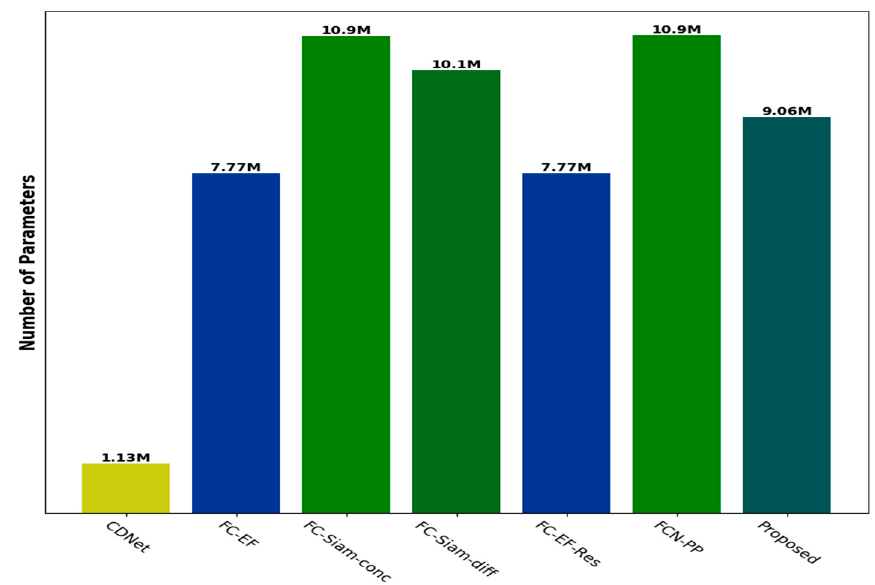
Figure 13. A comparison of network parameter size for different methods.